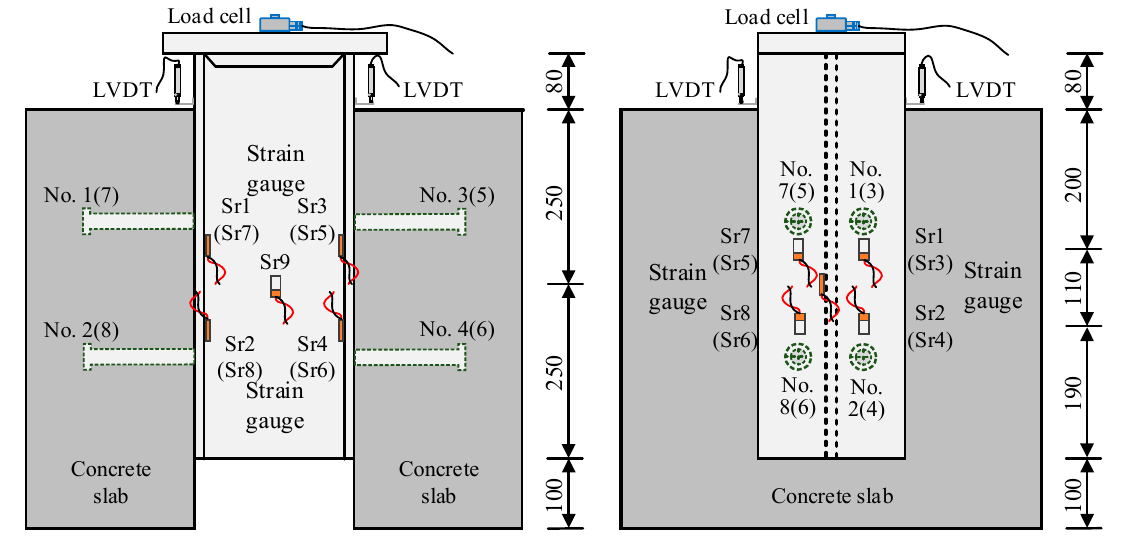
Figure 3. Test instruments and the layout. The push-out tests were carried out on a computer-controlled electro hydraulic servo fatigue testing machine, as shown in Figure 4. The loading frequency range of the fatigue testing machine was 1 Hz to 10 Hz. The maximum loading capacity of the actuator was 500 kN, both of which could realize force control and displacement control. The H-shaped steel column was loaded by an actuator through a steel drum (Figure 4). All the specimens were subjected to unidirectional loading during the static and fatigue tests.